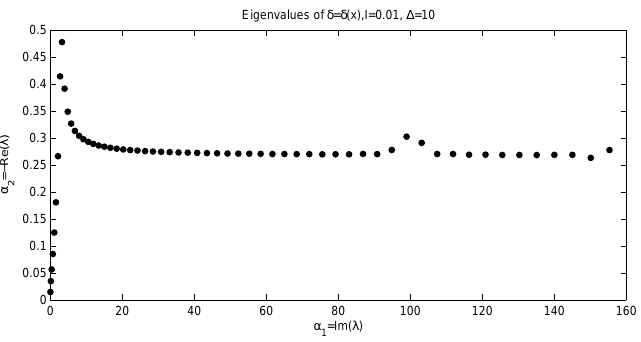
Figure 2. Eigenvalues α ( k ) of δ ( x ) , I = 0 . 01 , ∆ = 10 , n = 100(40)